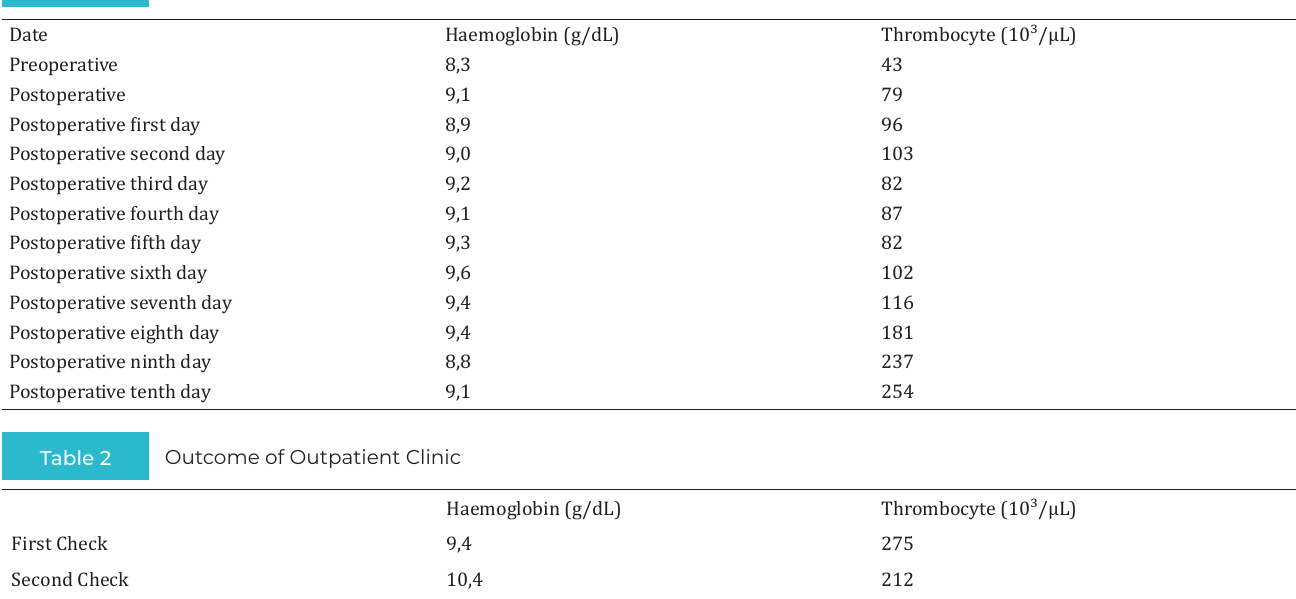
Early Postoperative